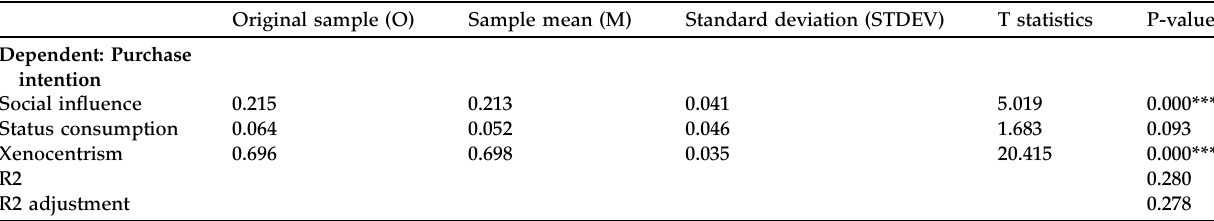
Table 2. Path coef fi cient results.